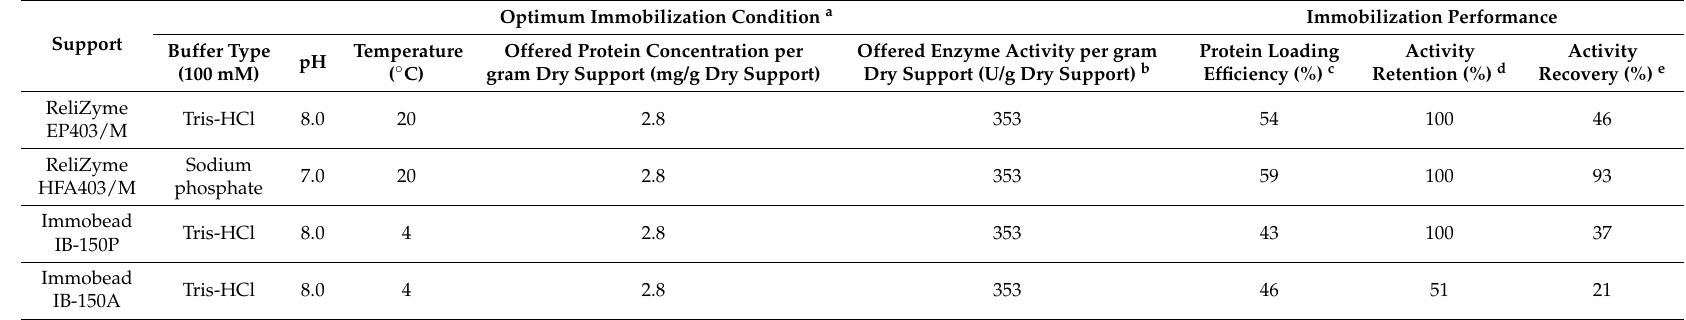
Table 2. Immobilization efficiency of TASKA on different